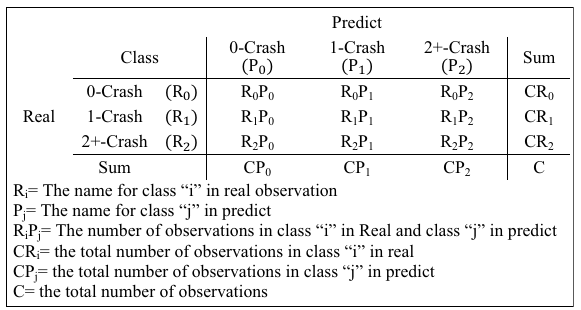
Figure 4. General confusion matrix for DT based